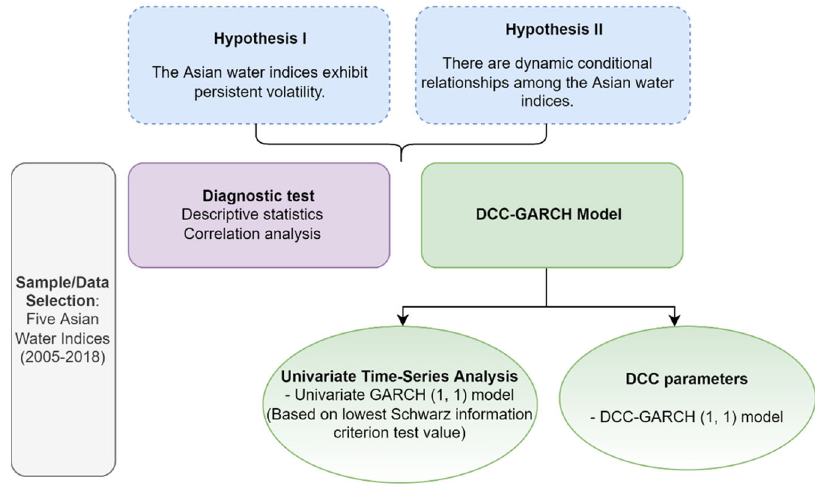
Fig. 2 Research methodology for the dynamic relationships among fi ve Asian water